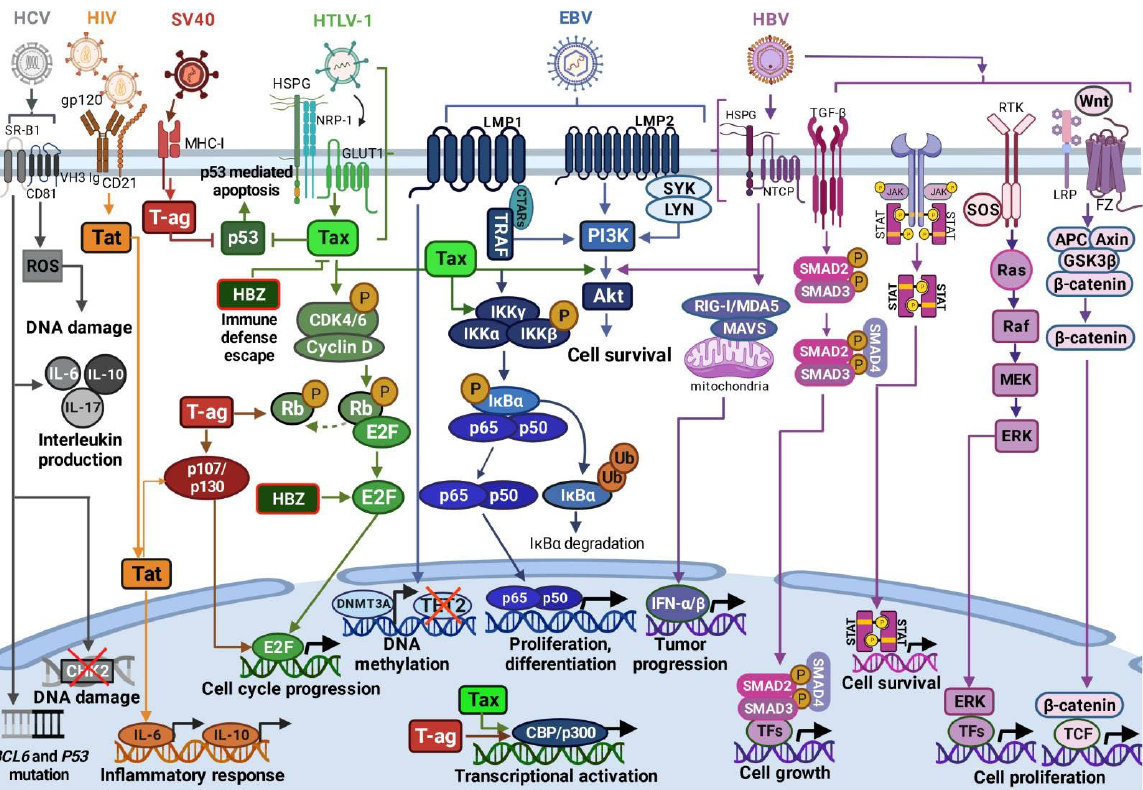
Figure 1. Mechanism of B-/T-cell infection by different viral agents and their effect on the intracellular signaling pathways involved in DLBCL tumorigenesis. The figure was created using BioRender (https://app.biorender.com/ (accessed on 21 July 2022)).